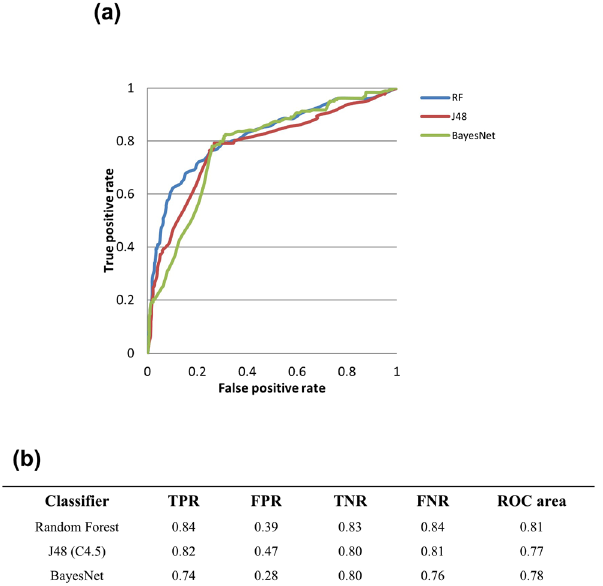
Figure 6. ( a ) ROC curves showing the relationship between TPR (sensitivity) and FPR (1-specificity) for the three ML algorithms used for model building. Most optimal results were obtained by RF with an accuracy of 84% and the AUC of 0.81. (b) 10-fold cross-validation performance measures of three